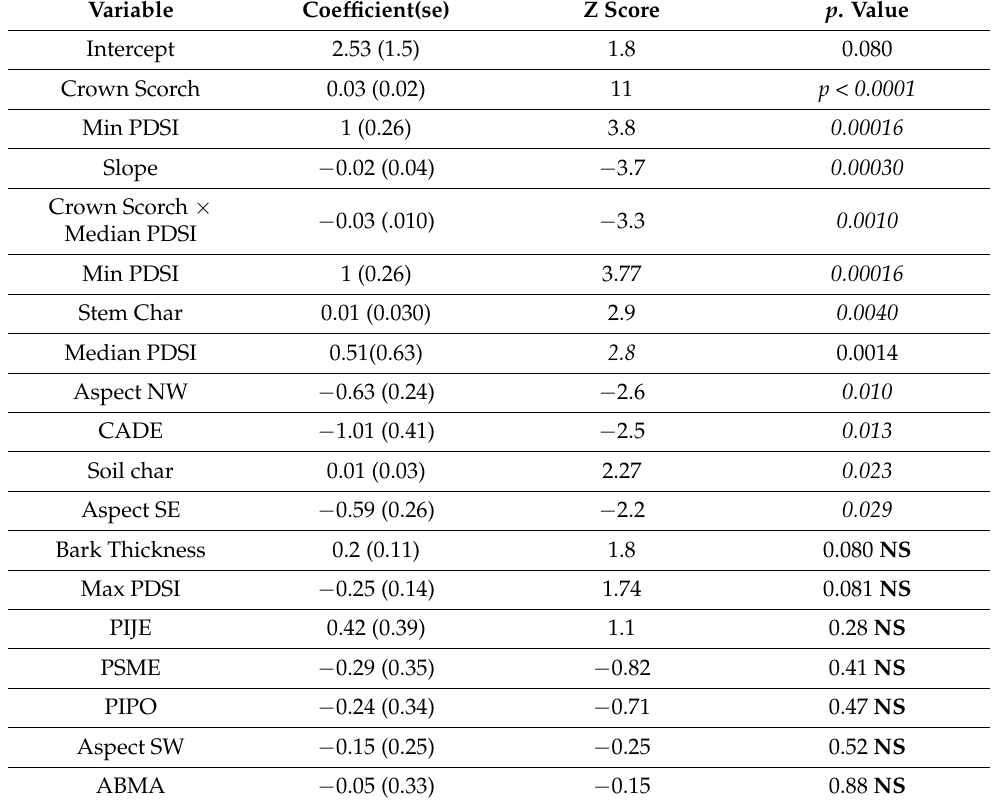
Table 4. Model coefficients (standard error), z score, and p -values for variables used in the delayed mortality logistic regression model by bark thickness, percent crown scorch, tree species (Canyon Live Oak as reference), soil char, stem char, min/max/median monthly ten-year PDSI, slope, aspect (NE as reference), and interaction between crown scorch and median monthly ten-year PDSI and soil char. After intercept, variables are ordered by p -value (significant predictors below p -value of 0.05 in italics). NS = non-significant at p -value of 0.05. Variable Coefficient(se) Z Score p . Value Intercept